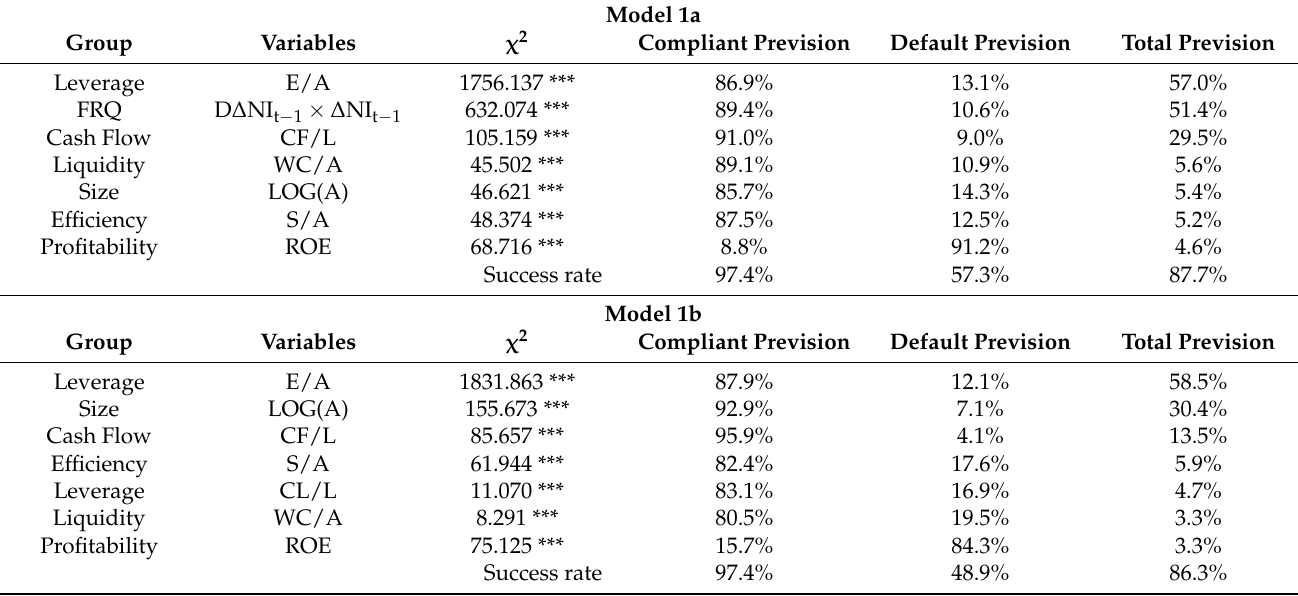
Table 6. Random forest